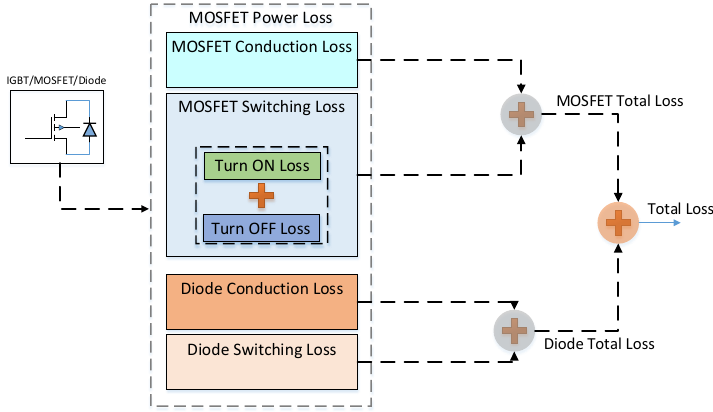
Figure 10. Total power losses block diagram of MOSFET.